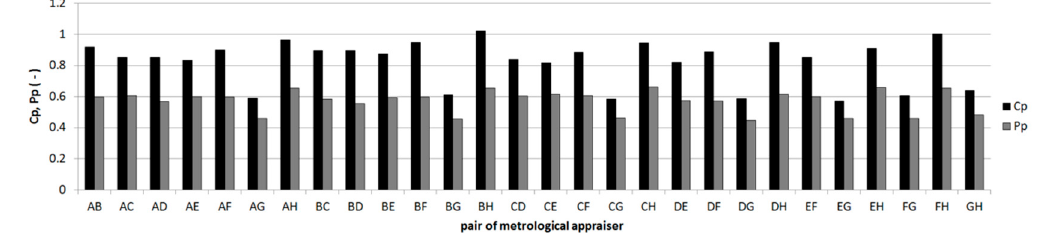
Figure 3. Value of C P and P P indices calculated from data measured by pairs of metrological appraisers.